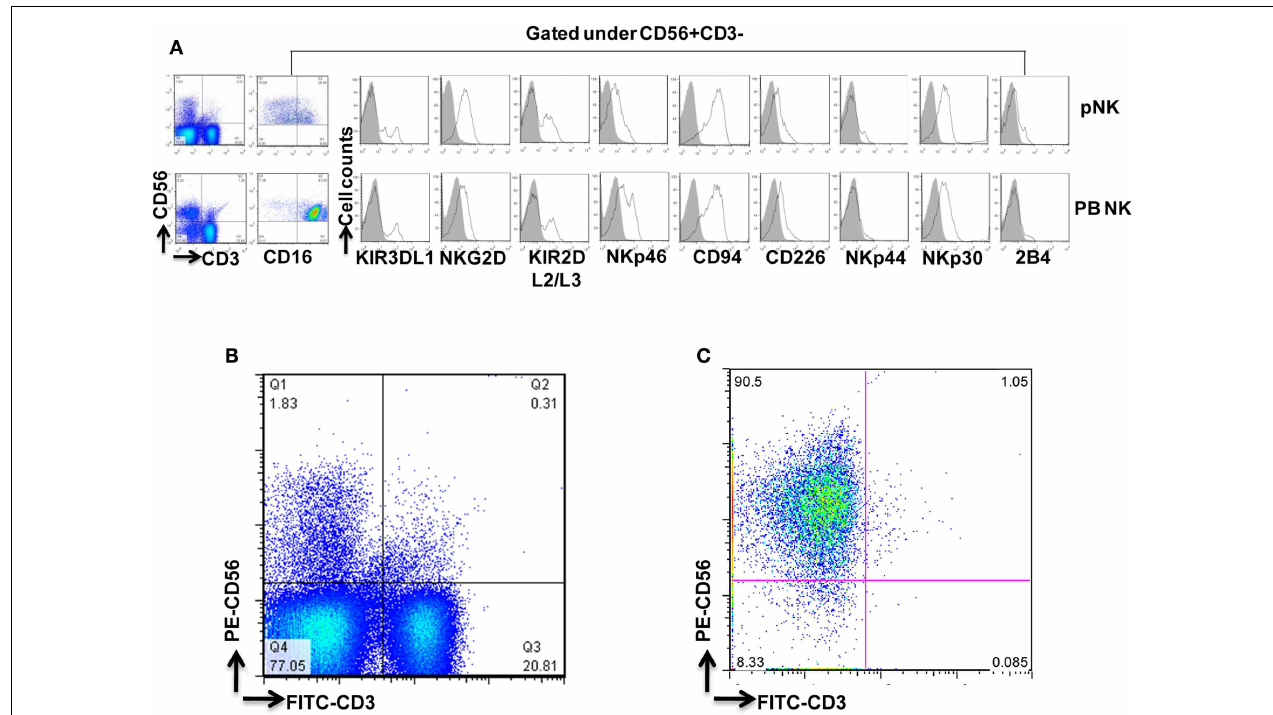
KIR2DL2/L3, NKp46, CD94, CD226, NKp44, NKp30, and 2B4. (B) Percentage of CD56 + CD3 − pNK cells from Combo unit prior to NK cell isolation. (C) About 90% CD56 + CD3 − NK cells from Combo unit was achieved after NK cell isolation.